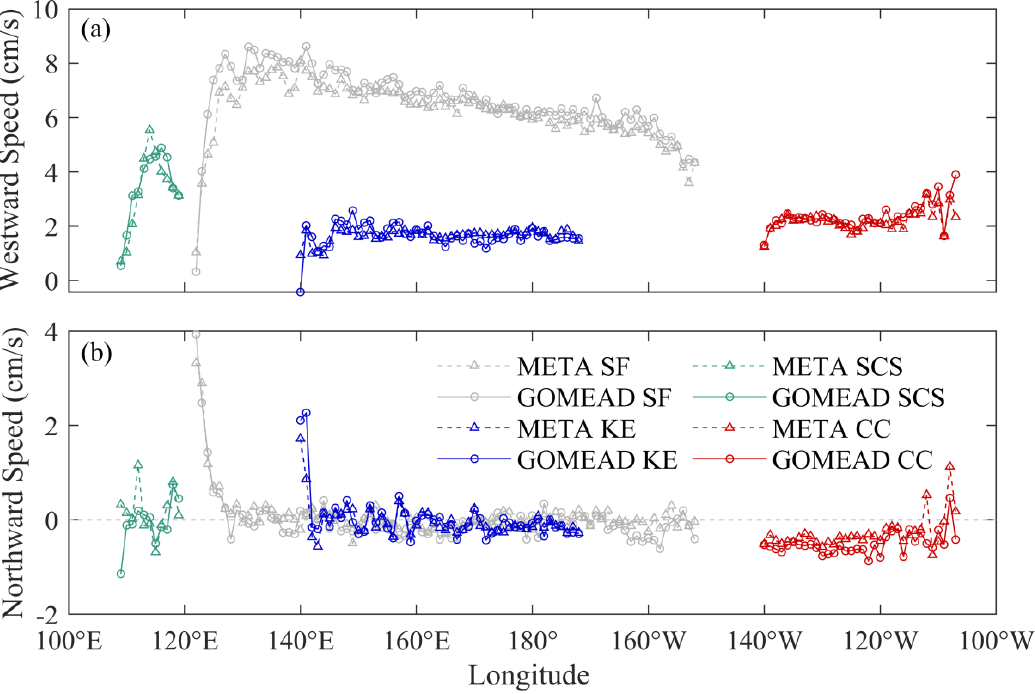
Figure 16. Variations of ( a ) westward speeds and ( b ) northward speed of AEs by longitude. Dashed and solid curves represent the META and GOMEAD datasets, respectively.